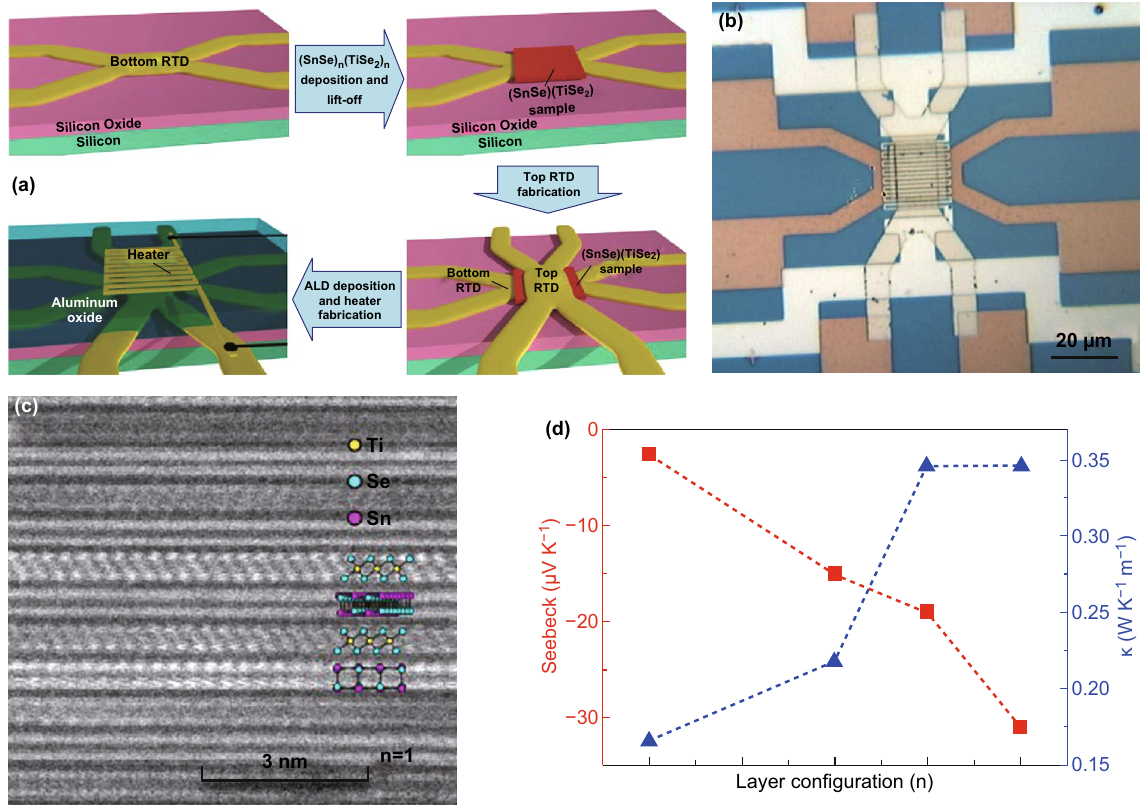
Fig. 16 a Schematic diagram of the device fabrication process, and b its optical microscope image. c STEM images of the (SnSe) n (TiSe 2 ) n thin film ( n = 1). d Cross-plane Seebeck coefficient and thermal conductivity of the (SnSe) n (TiSe 2 ) n thin film with different layer configurations. Reproduced with permission from Ref. [252]. Copyright 2017, American Chemical